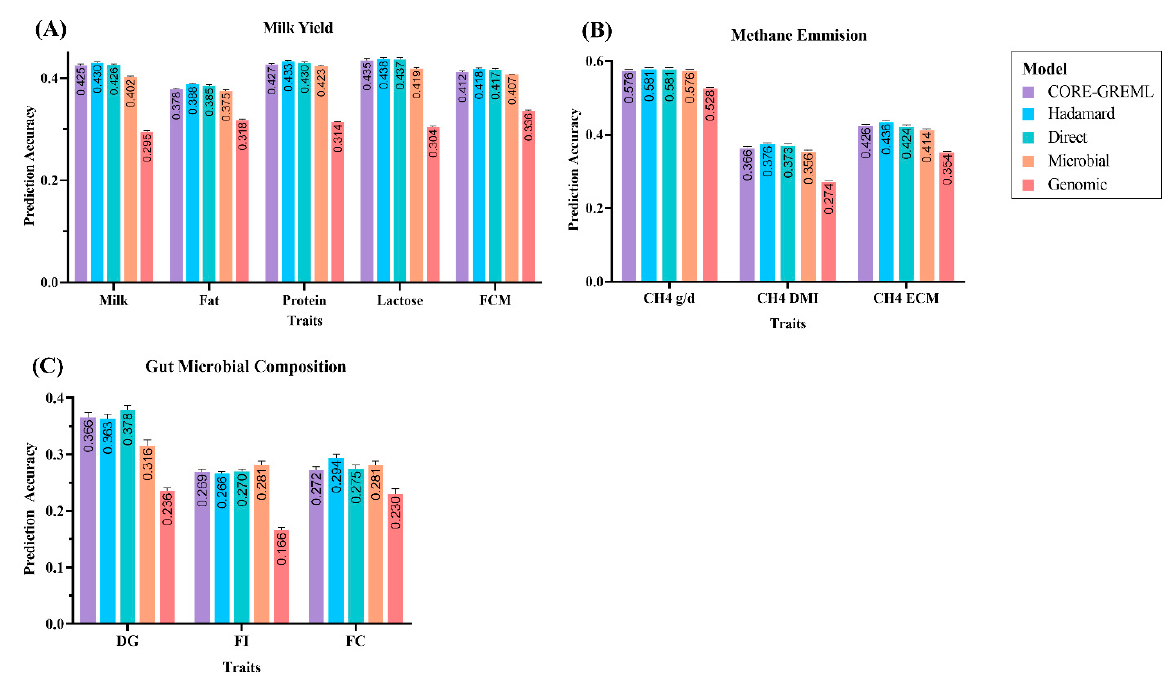
Figure 2. ( A ) Prediction accuracy ( r² ) of different models in milk yield traits ( p < 0.0001). ( B ) Predic- tion accuracy ( r² ) of different models in methane emission traits ( p < 0.0001). ( C ) Prediction accuracy ( r² ) of different models in gut composition traits ( p < 0.0001).